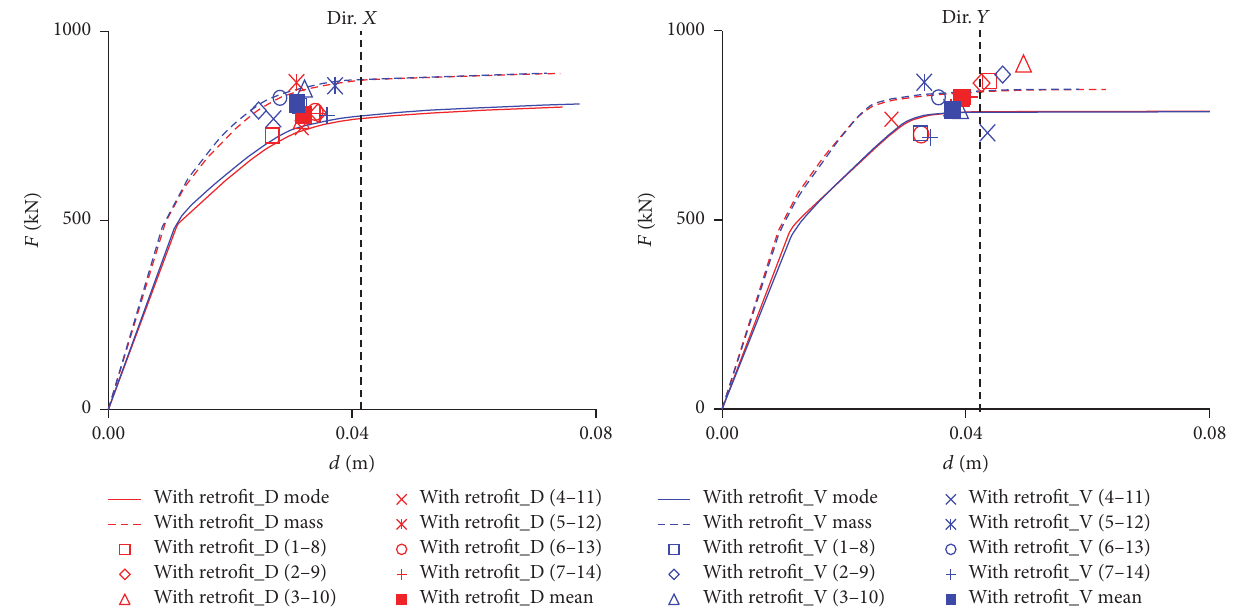
Figure 8: Comparison between the results of NLSA and the maximum top displacements versus base shears by